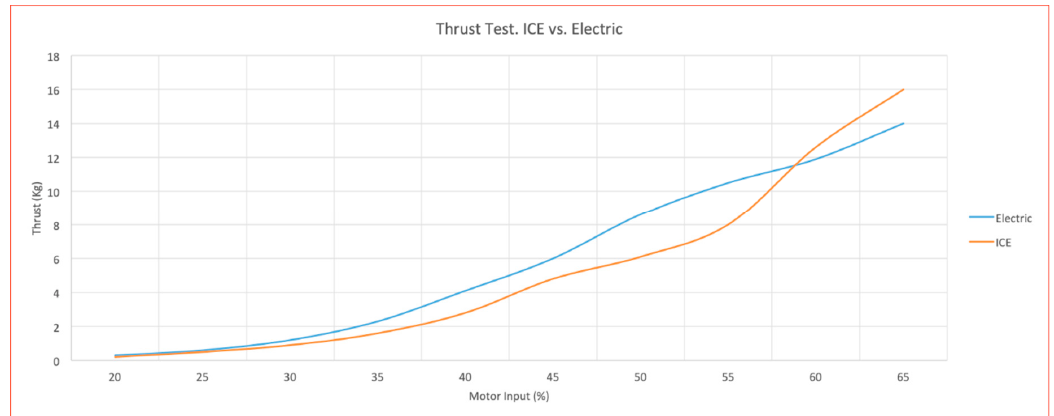
Figure 23. Electric ALO thrust test. Electric power vs. thrust.